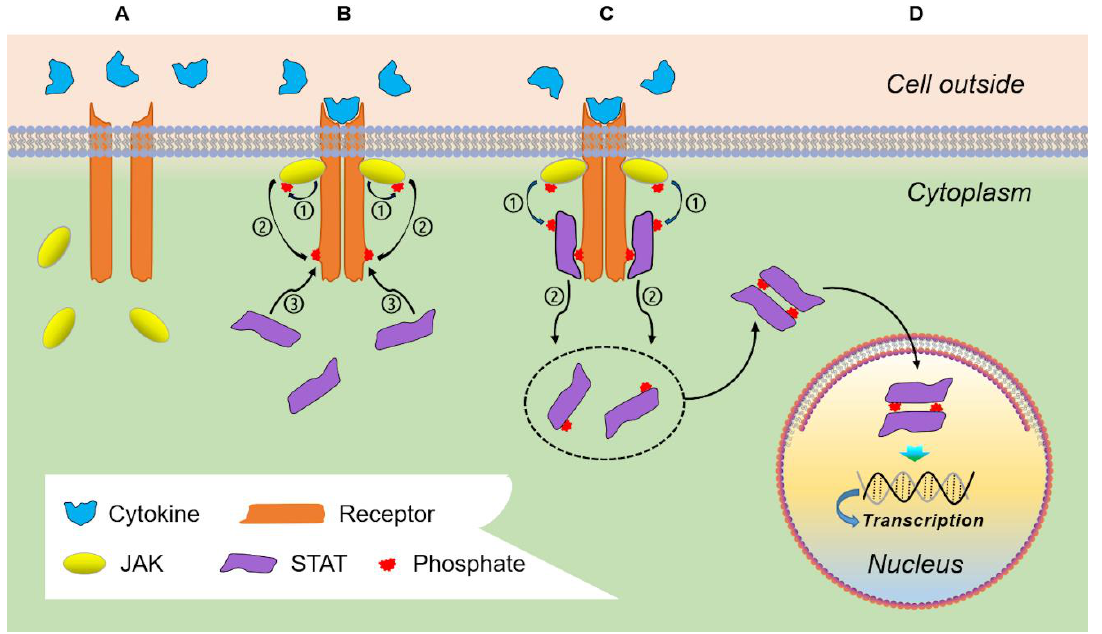
Figure 1. Physiologic JAK-STAT signaling. The classical JAK/STAT signaling pathway begins with ( A ) recognition and binding of an extracellular cytokine by its respective receptor leading to ( B ) receptor dimerization, docking of JAK protein, JAK autophosphorylation, and phosphorylation of the receptor’s cytoplasmic tail. STAT proteins are then able to ( C ) bind via their SH2 domains to these activated receptors, undergoing the critical activating step of tyrosine phosphorylation that allows them to dimerize with other STAT proteins and ( D ) translocate to the nucleus to effect transcription of target genes.